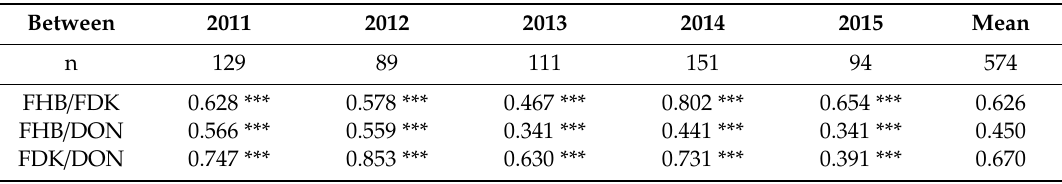
Table 3. Correlations between FHB traits disease index, FDK, and DON in advanced breeding lines and cultivars, Szeged, 2011–2015 [75].